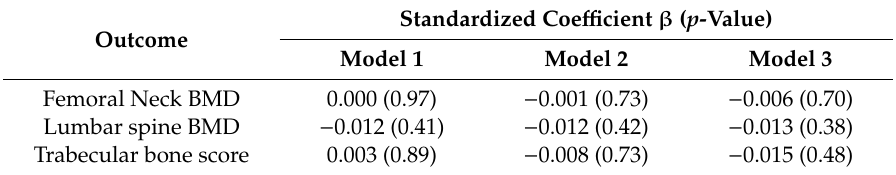
Table 2. Association of energy-adjusted carboxymethyllysine (CML) with femoral neck and lumbar spine bone mineral density (BMD) and trabecular bone score (TBS) in the whole population ( N =